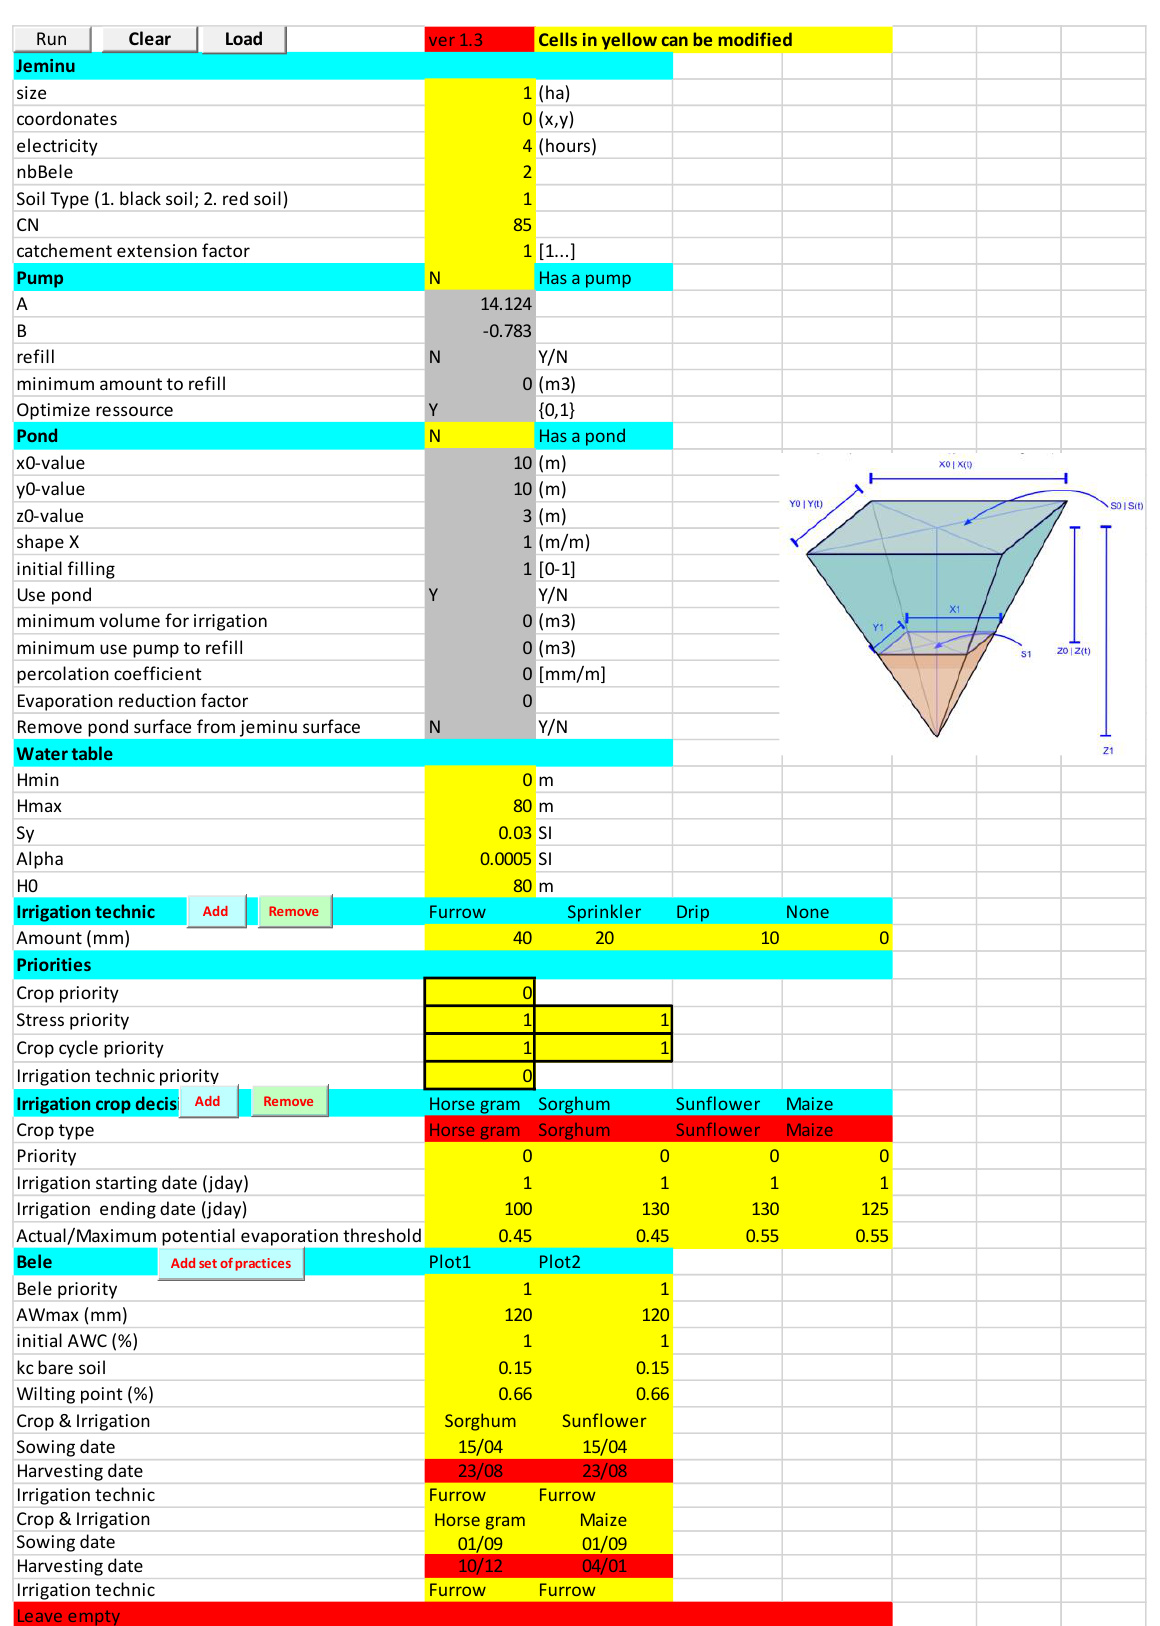
Figure 3. The upper screen of the graphic user interface. This Graphic User Interface allows for parametrizing of the simulation. Information and data validation are performed at this step.